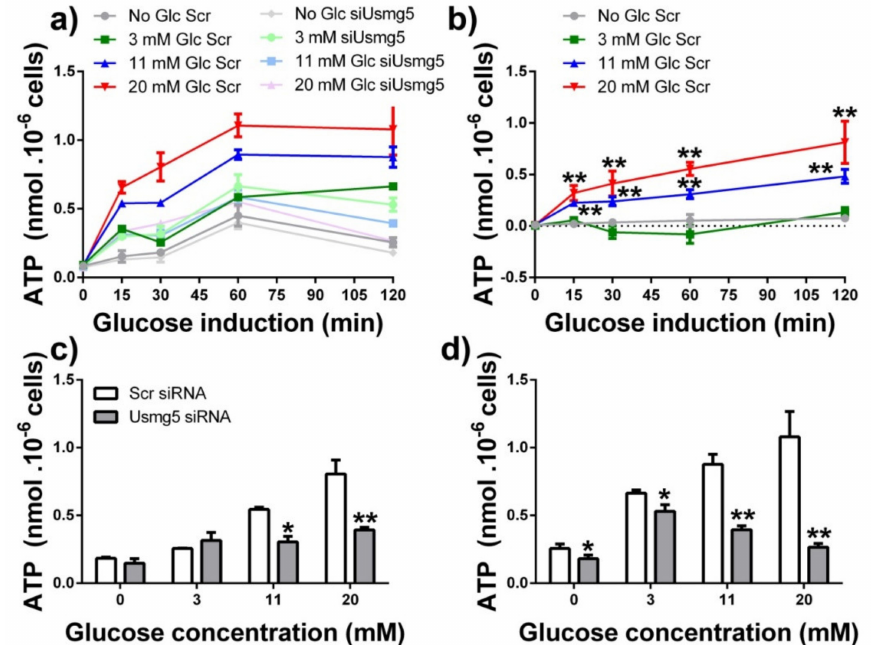
Figure 6. ATP levels in INS-1E cells. ( a ) Time course of the total ATP levels upon glucose induction in INS-1E cells transfected with scrambled siRNA (color coding as in Figure 1) or Dapit / Usmg5 siRNA as indicated; ( b ) DAPIT-dependent part of the total ATP levels (data for Dapit siRNA were subtracted from data of scrambled sequence containing siRNA) after glucose induction; ( c , d ) Glucose dependencies constructed from the data of panel ( a ). p < 0.001 for 11 and 20-mM glucose in ( c , d ). Data were significantly di ff erent from zero (3 mM) glucose data as indicated ( N = 3): ** p < 0.05; * p <